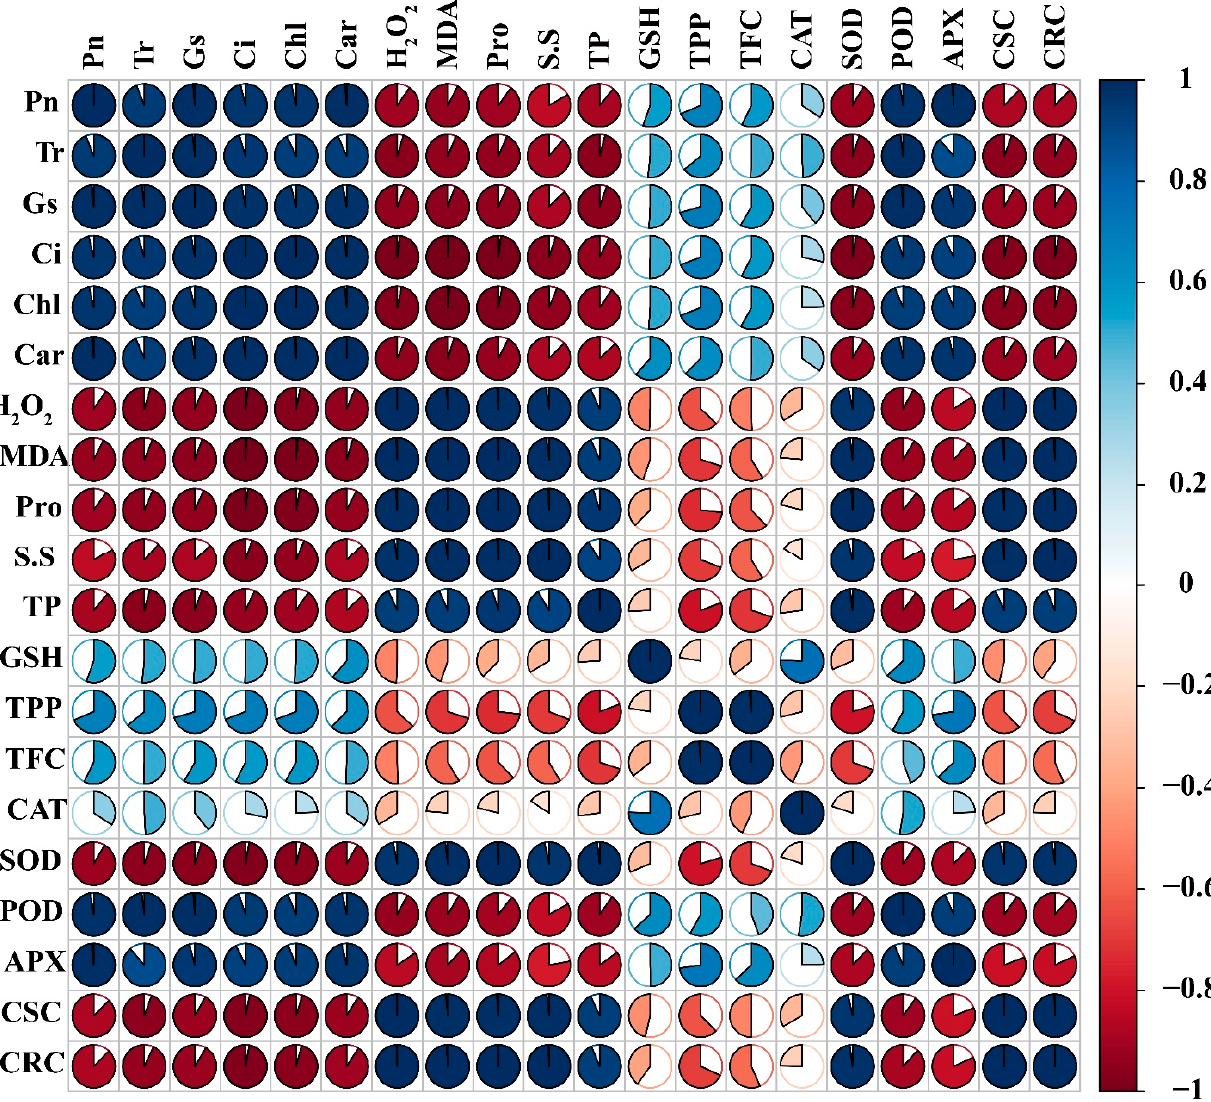
Figure 8. Pearson’s correlation analysis ( p < 0.05) was measured between different physiological and biochemical traits of sweet potato. Pn (photosynthetic assimilation), Tr (transpiration rate), Gs (stomatal conductance), Ci (Intercellular CO 2 ), Chl (total chlorophyll), Car (carotenoids), H 2 O 2 (hydrogen peroxide), MDA (malonaldehyde), Pro (proline). S.S (soluble sugars), TP (total proteins), GSH (reduced glutathione), TPP (total polyphenols), TFC (total flavonoids), CAT, SOD, POD, APX, CSC (Cr shoot concentration), and CRC (Cr root concentration).